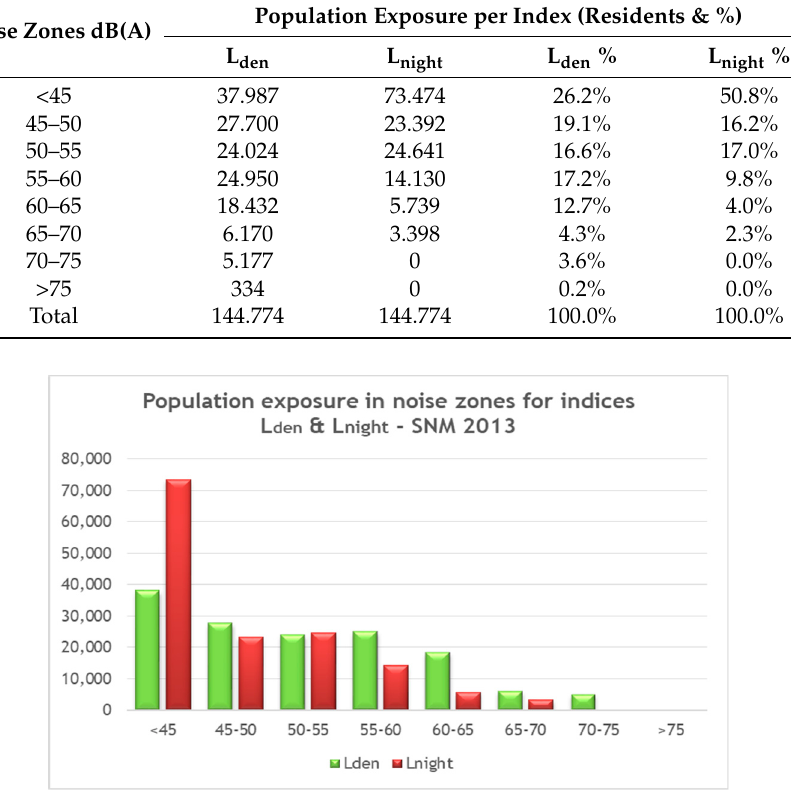
Figure 5. Heraklion Strategic Noise Map (SNM)—population exposure in noise zones for indices L den & L night.